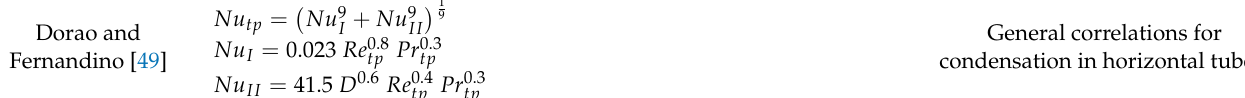
General correlations for condensation in horizontal